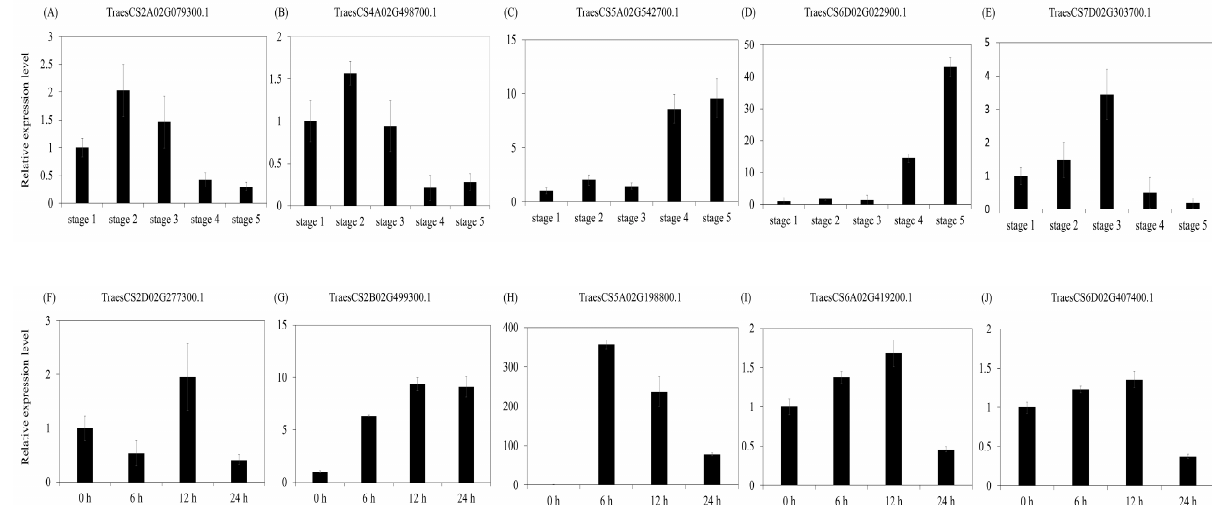
Figure 9. Validation of RNA-seq results by qRT-PCR in wheat at different developmental stages and drought stress conditions. ( A – E ) Stage 1 (leaf: three leaves emerged, Z13), stage 2 (leaf: main stem and four tillers present, Z24), stage 3 (leaf: leaf at the tip of ear just visible, Z51), stage 4 (spikelet: beginning of anthesis, Z61), and stage 5 (spikelet: early milk development, Z73) are shown. Z, Zadoks growth scale. ( F – J ) Seedlings in the three-leaf stage on Hoagland solution were treated with 20% PEG 6000 for simulation of drought stress; then, samples were collected 6, 12, and 24 h after treatment. All samples were normalized to the actin gene. The data are presented as the average ± standard error ( n = 3).